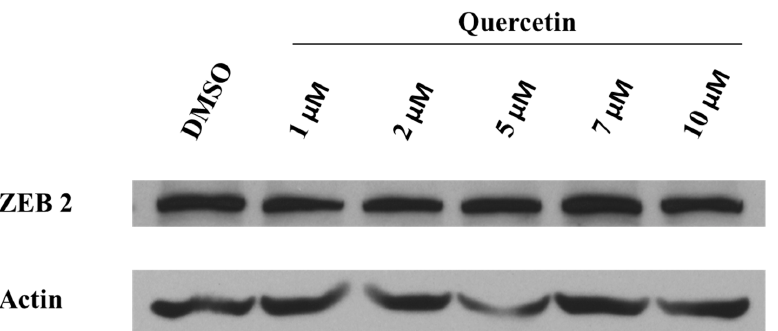
Figure A1. Representative Western blot demonstrating the modulation of ZEB2 expression by quercetin in Hep G2 cells. Hep G2 cells were seeded and incubated with different concentrations of quercetin for 24 h. Negative control contains only DMSO.